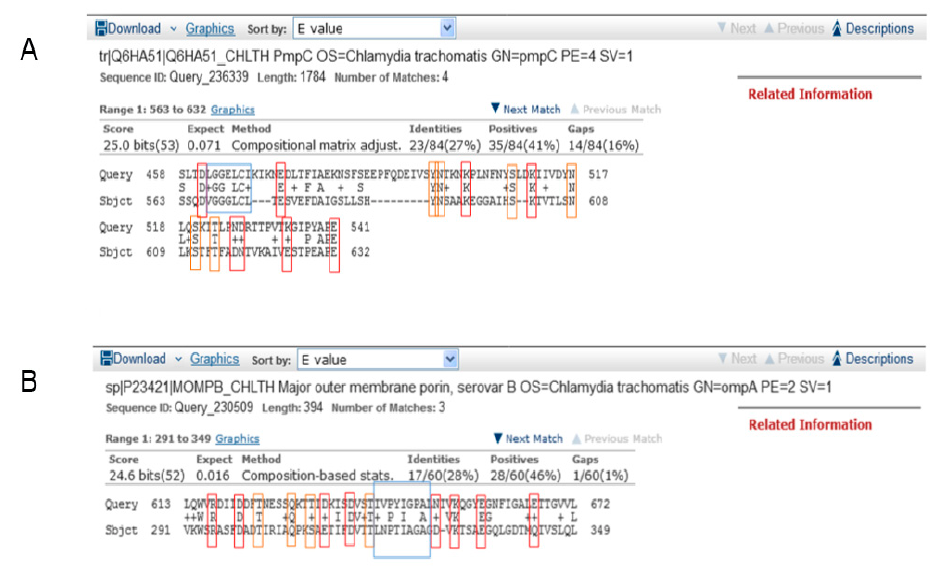
Figure 1. Amino acid sequence homology of the short peptide sequences of chlamydial proteins PmpC and MOMP-B with the tetanus toxin (TeNT). The parameters on the BLASTp network server were automatically set. The maximum overlaps of the TeNT amino acid sequence (Sbjct) and amino acid sequences of ( A ) PmpC and ( B ) MOMP-B (Query) are shown. The polar-charged amino acids are marked in red, the polar-uncharged amino acids are marked in orange, and the hydrophobic amino acids are marked in blue.